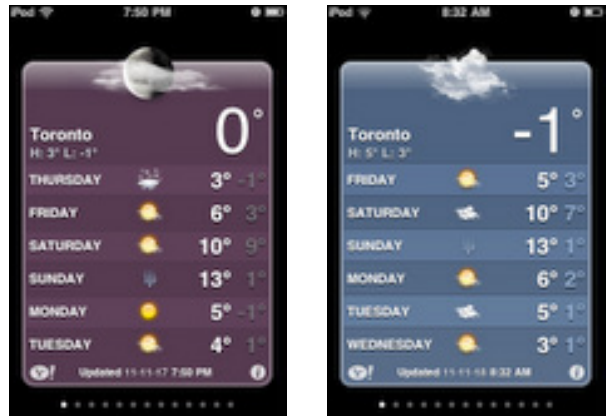
Figure 4. The weather